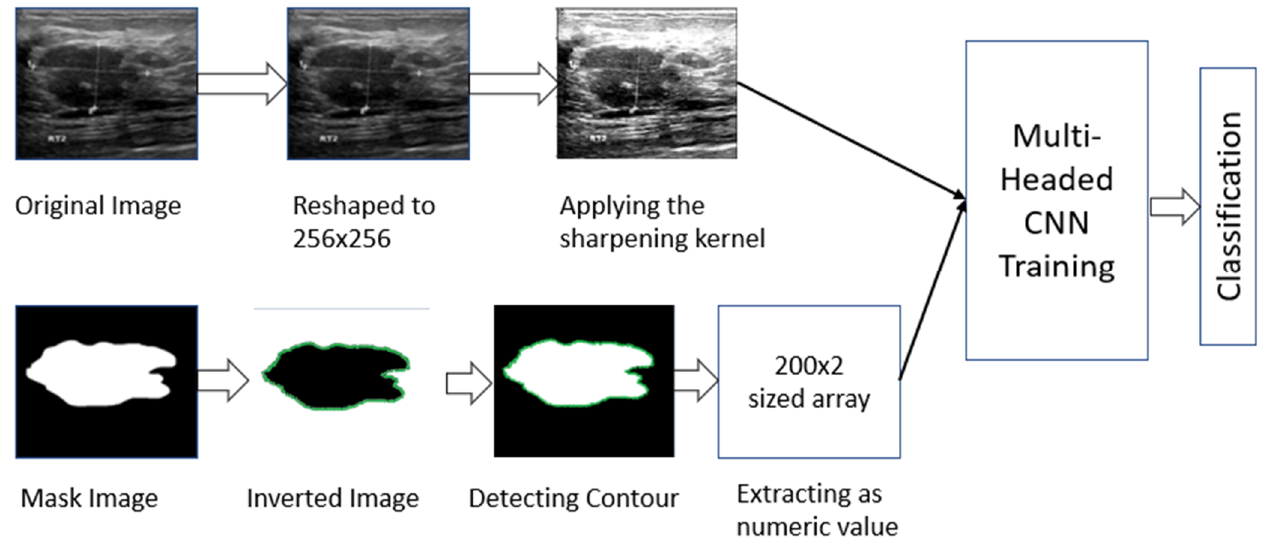
Figure 2. Working procedure of multi-headed concept.